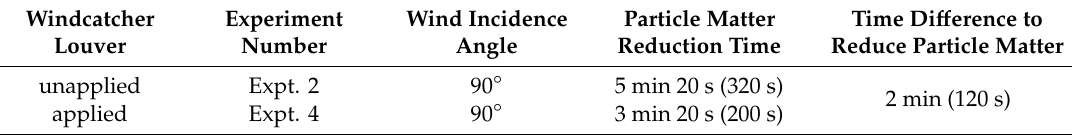
Table 9. Particulate matter reduction with or without a windcatcher louver.